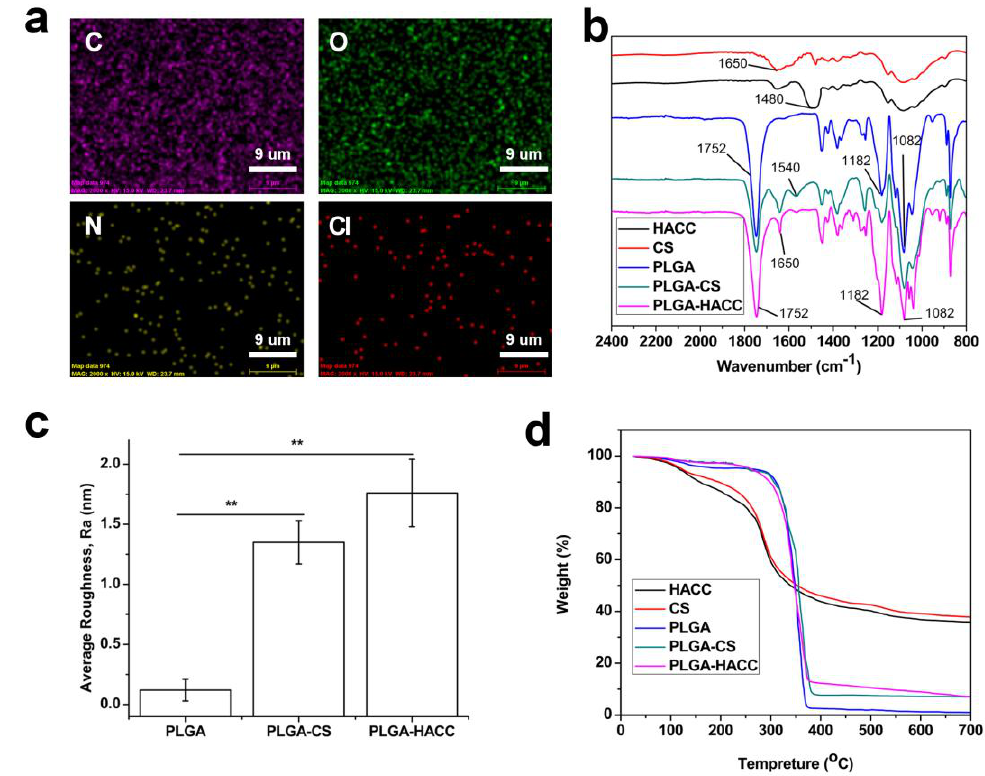
Figure 2. EDX mapping of C, O, N and Cl distribution within PLGA-HACC fibrous membranes ( a ); ATR-FTIR spectra ( b ); average roughness (Ra) of PLGA HACC and PLGA-CS and PLGA-HACC membranes ( c ) and TGA thermogram curves of the CS, PLGA, HACC and PLGA-CS and PLGA-HACC fibrous membranes ( d ); ** indicates p < 0.05.